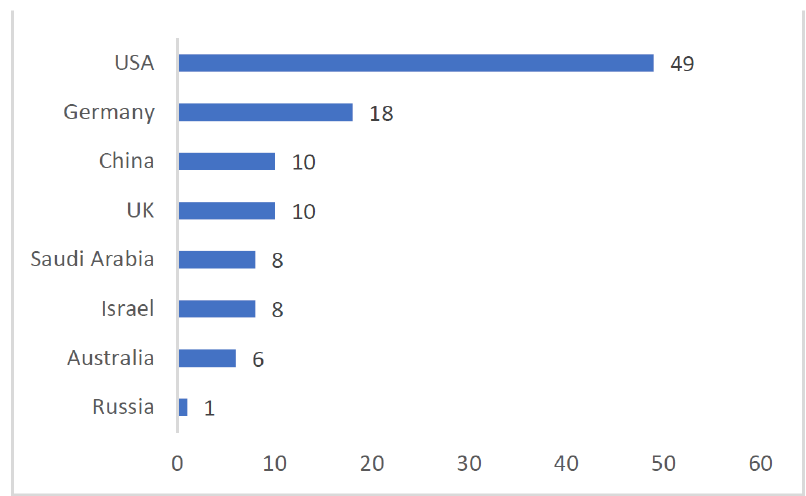
Figure 4. Ranking of countries of origin of first authors.